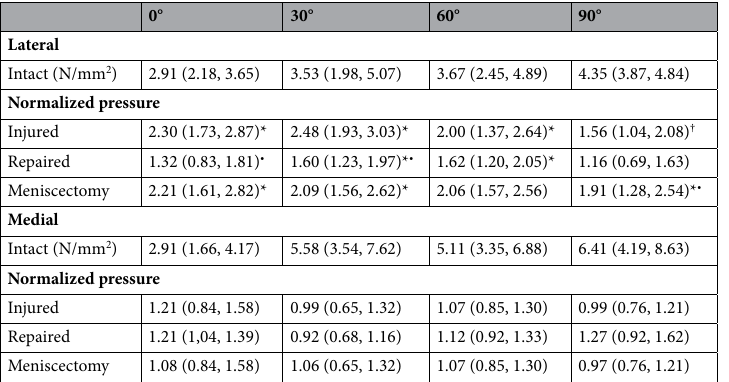
Table 3. Normalized peak pressure relative to the intact condition in the lateral and medial compartments at each flexion angle for the 3 altered meniscal conditions (given as mean value with the 95% CI in parentheses). Values of peak pressure (N/mm 2 ) in the Intact group are provided for reference. *Significant difference with respect to the intact condition. † Significant difference with respect to meniscectomy. • Significant difference with respect to